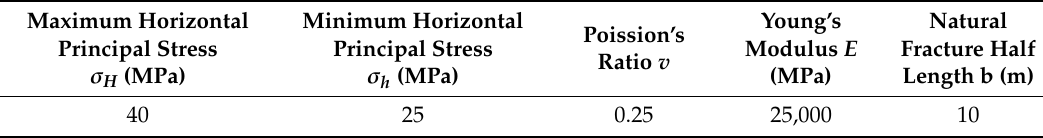
Table 1. The basic data from the model analysis.